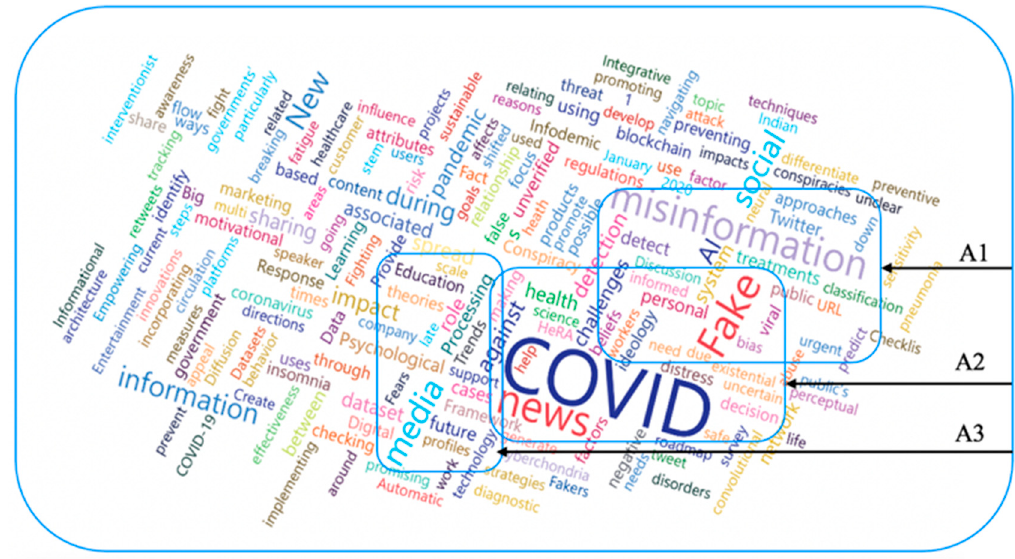
Figure 5. A word cloud of all papers we surveyed.